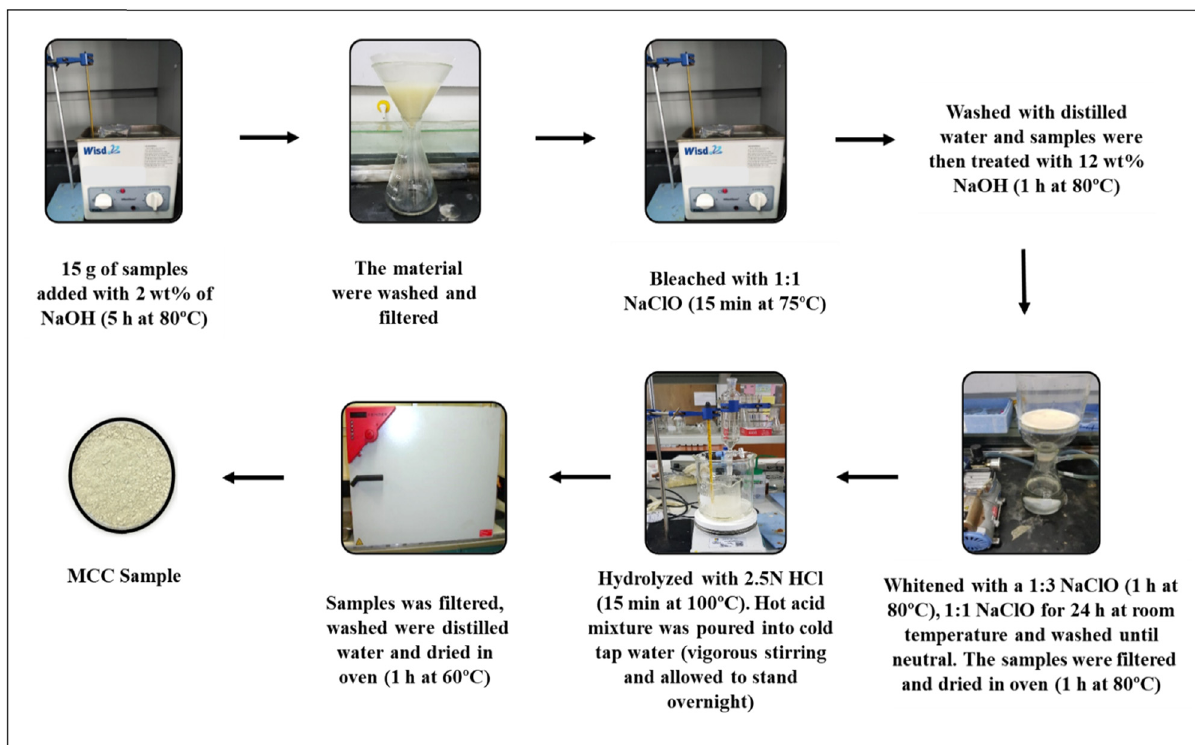
Figure 2: Procedures of preparation of MCC from pineapple